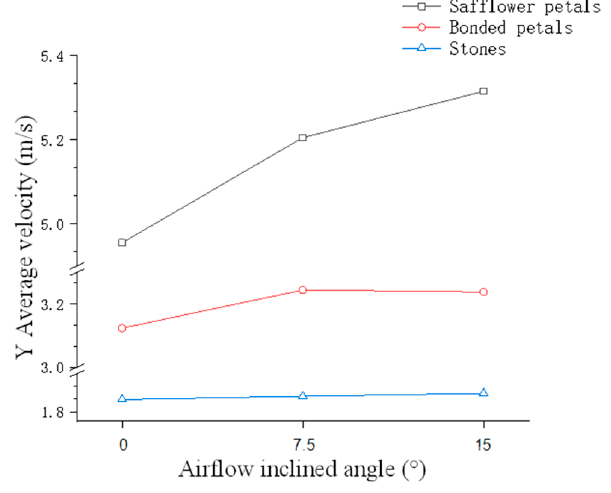
Figure 14. The influence of the airflow inclined angle on the axial average velocity of the mixture components.